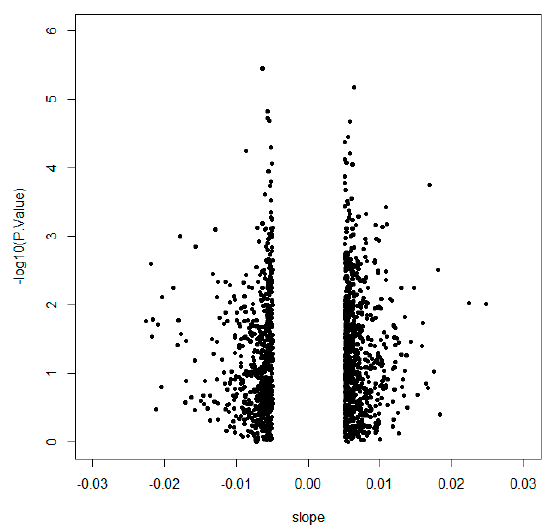
Figure 1. Volcano plot representing 1416 CpGs selected by slope >|0.005| according to the logarithm of the p -value obtained from Spearman correlation with calculated insulin sensitivity index (CSi).